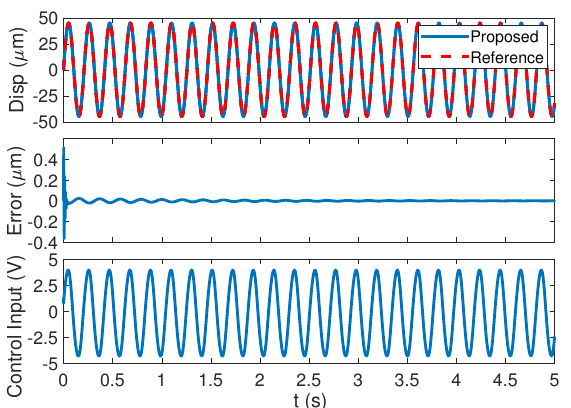
Figure 6. Simulation results of the sinusoid signal tracking via the proposed control algorithm (30 rad/s).